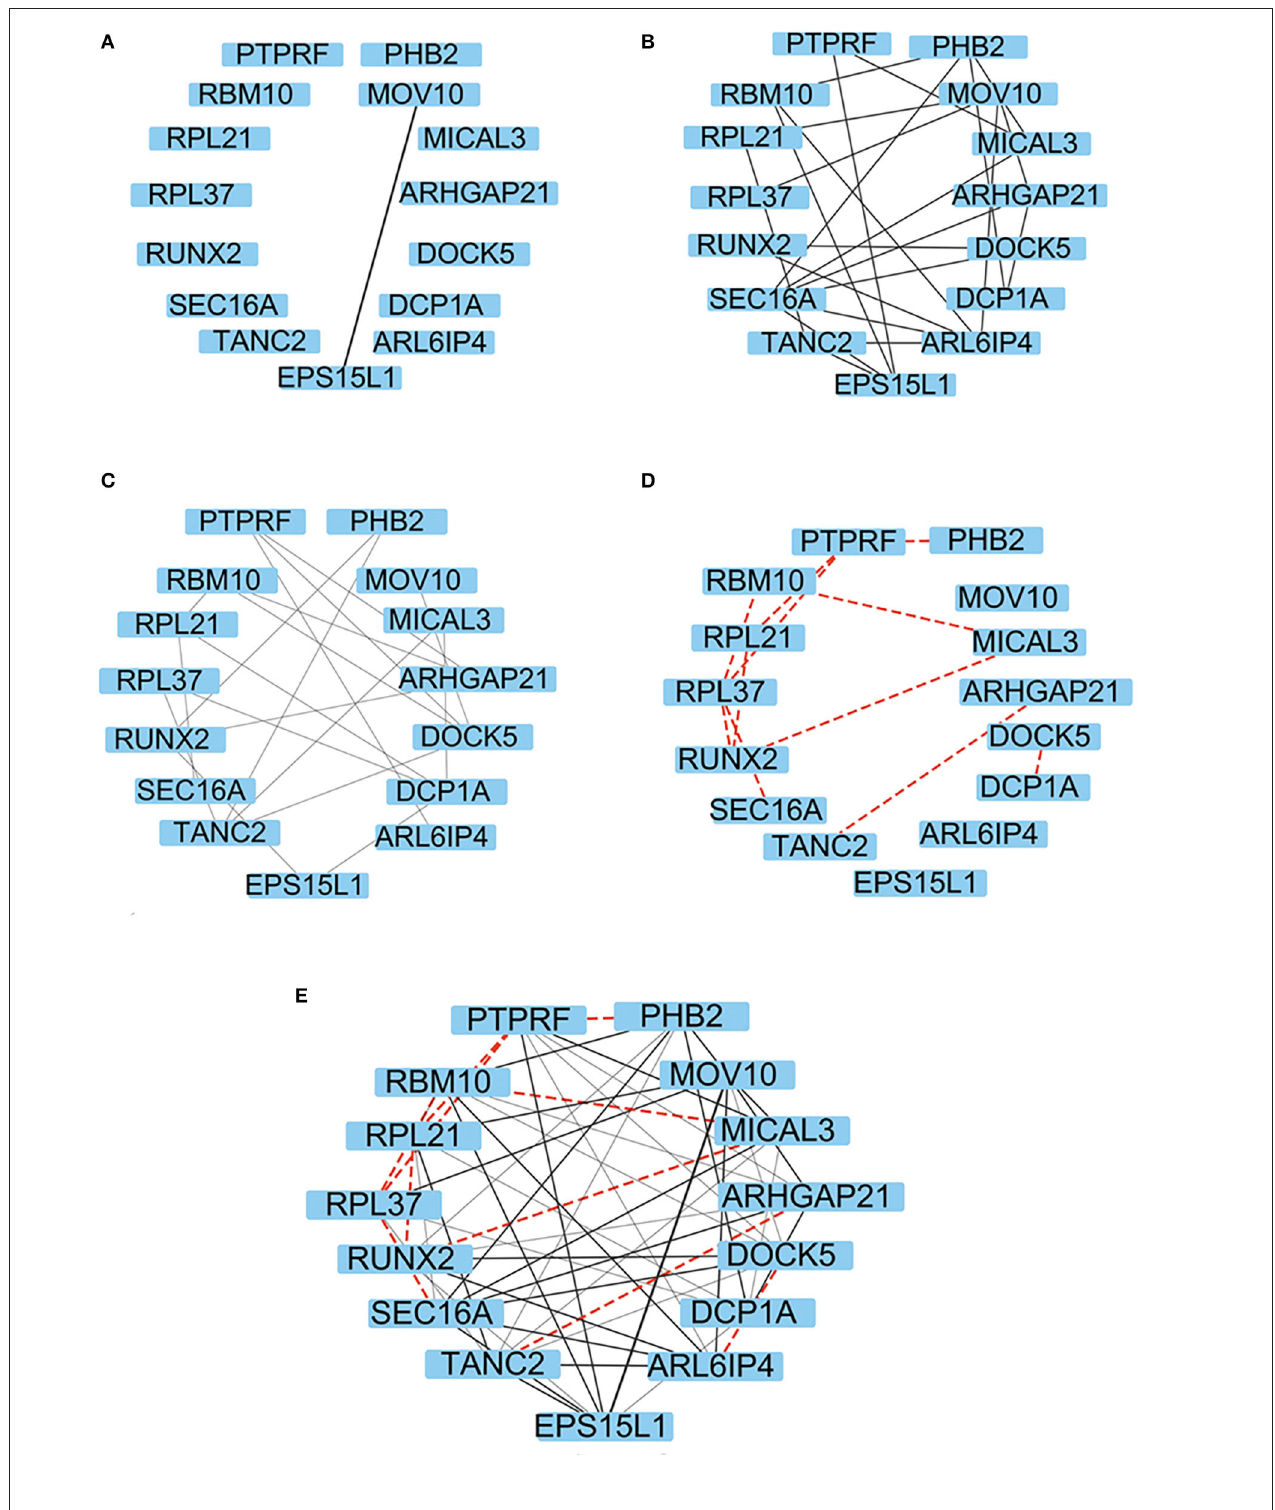
FIGURE 6 | The representation of the association rules/PPIs revealed by DCAA. (A–C) The representation of the PPIs recorded in the DIP revealed by DCAA using different reasoning modes, namely, direct connection (A) , twofold reasoning (B) , and threefold reasoning (C) . (D) Representation of the PPIs that were predicted by DCAA but were not recorded in the DIP. The black solid lines represent the PPIs recorded in the DIP. The red dashed lines represent the PPIs predicted by DCAA. The thickness represents the distance of the relationship; the thicker the line is, the closer the relationship is (E) Representation of PPIs that were combined with the results of (A–D)